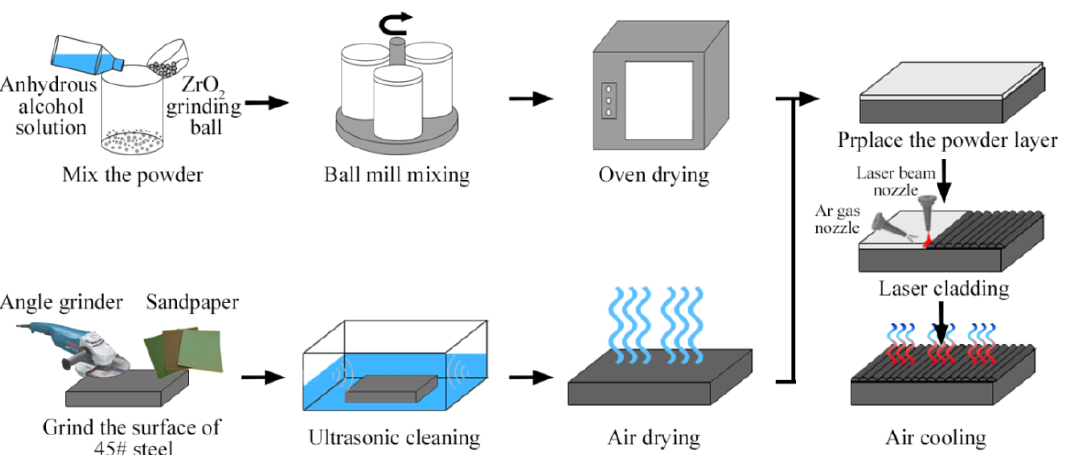
Figure 2. Schematic diagram of the preparation process of laser cladding the Inconel 718/TiB 2 composite coating.